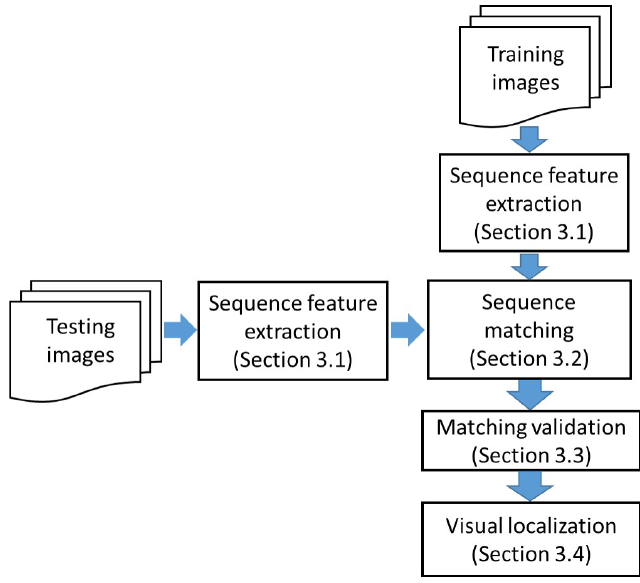
Figure 2. Flow chart of proposed visual localization using sequence